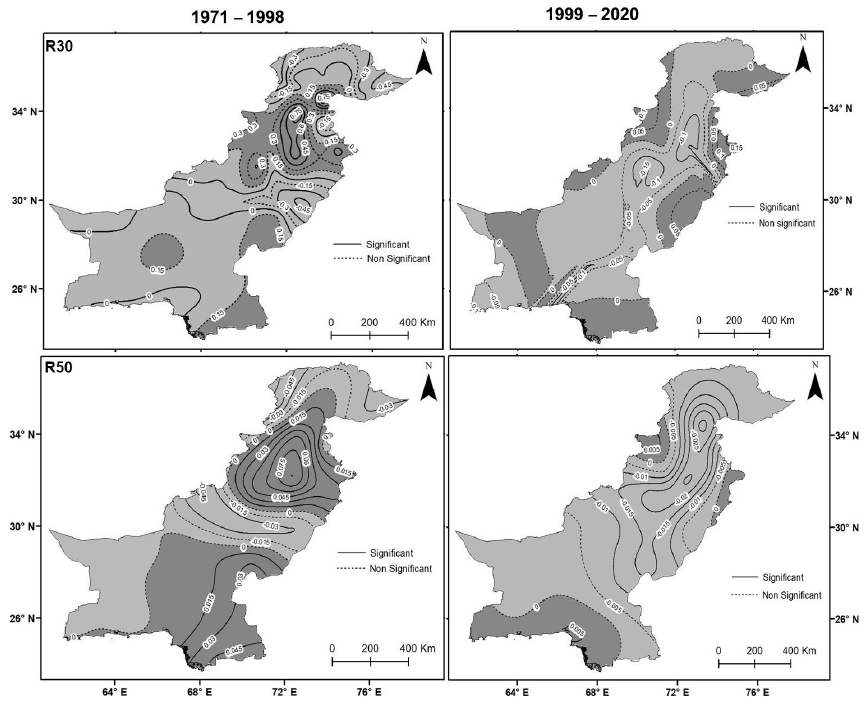
Figure 8. Spatial trends for extreme precipitation indices R30 and R50 (days) during 1st and 2nd data period. Dark color indicates the positive changes and light color shows the negative changes at 0.05 level of significance.